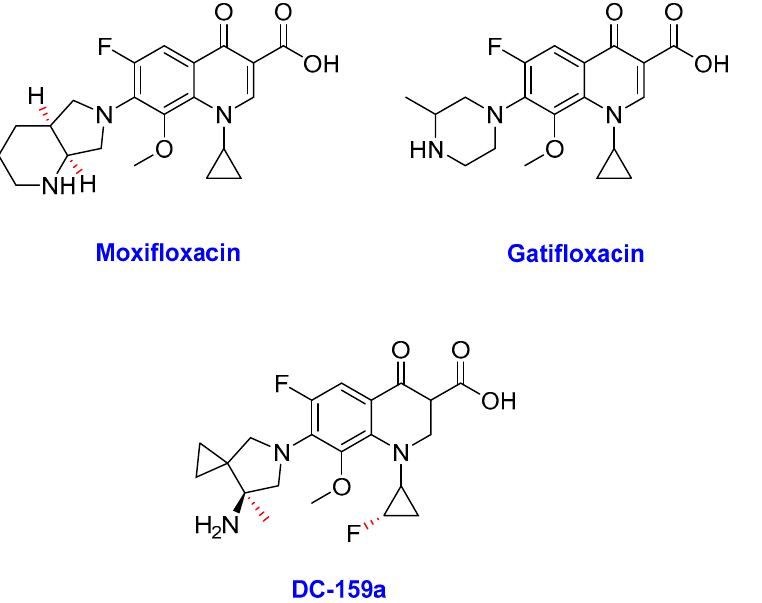
Figure 1. The chemical structures of potential anti-TB fluoroquinolones. MFX is readily absorbed from the gastrointestinal tract following oral administration. (Cmax) of 3.4 mg/L was reached in 1.5 h (Tmax), and its area under the curve (AUC) was